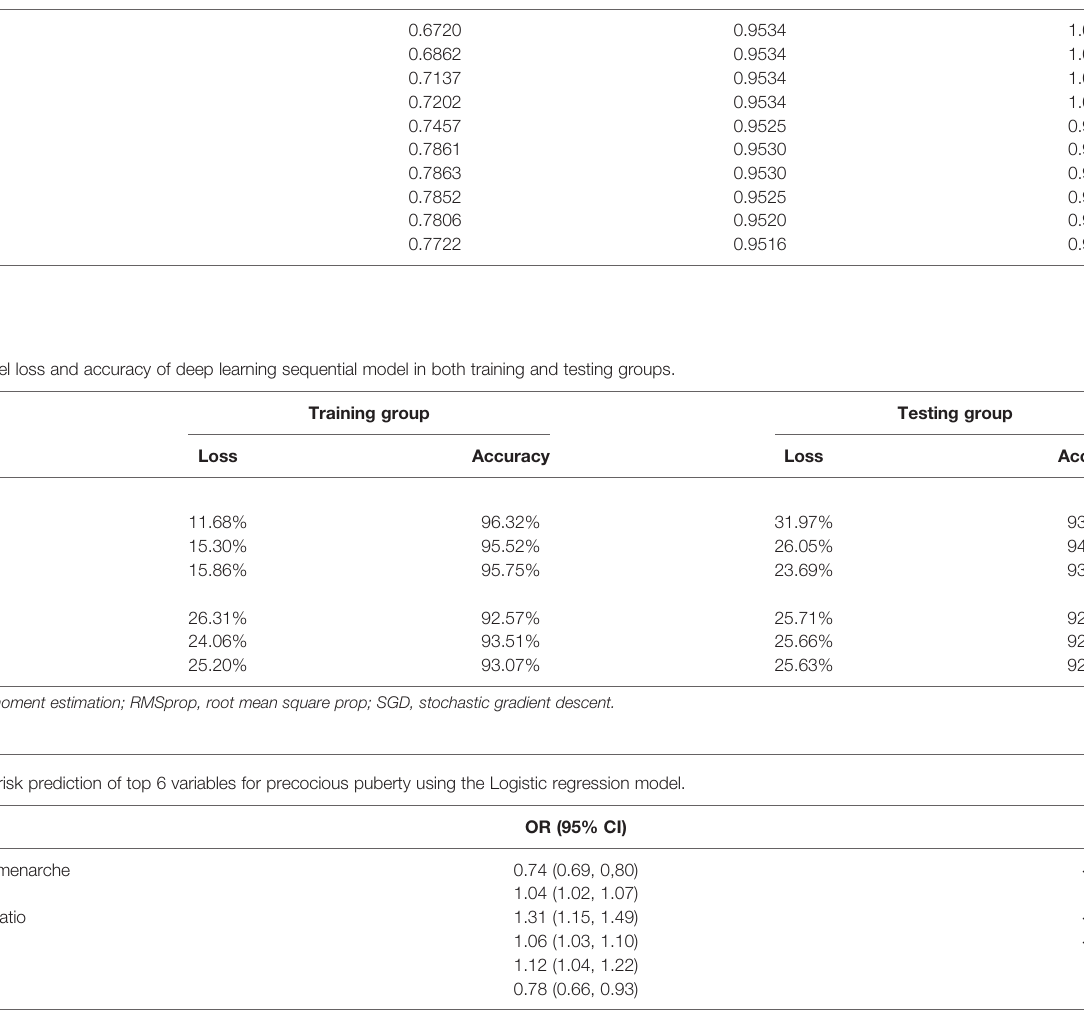
OR, odds ratio; 95% CI, 95% con fi dence interval.